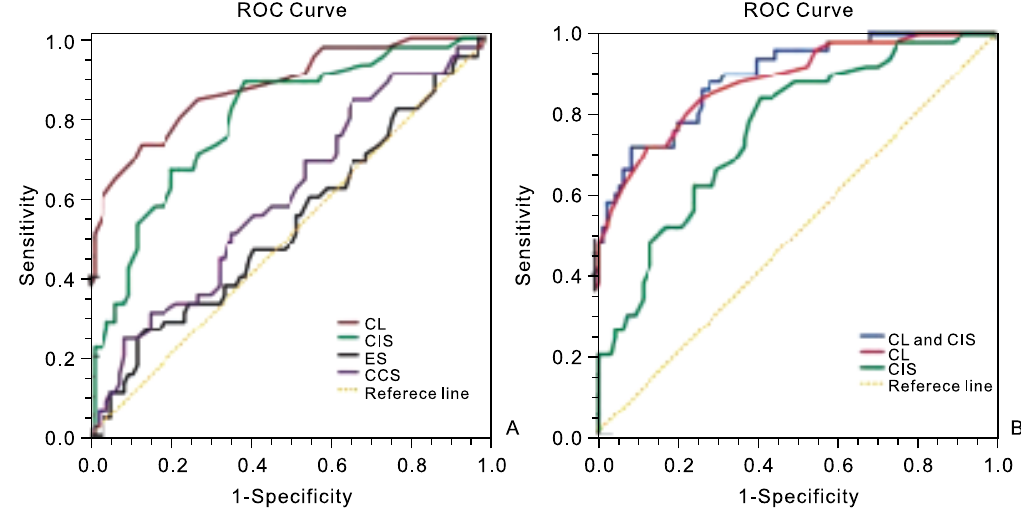
Figure 2 (A) The ROC curve for strain value of CL, CIS, ES and CCS ( n = 152). (B) The ROC curve for strain value of CL, CIS and combination of CL and CIS ( n = 152). ROC, receiver operating characteristic; CL, cervical length; CIS, closed internal cervical os strain rate; ES, external cervical os strain rate; CCS, the midpoint of the cervical canal strain